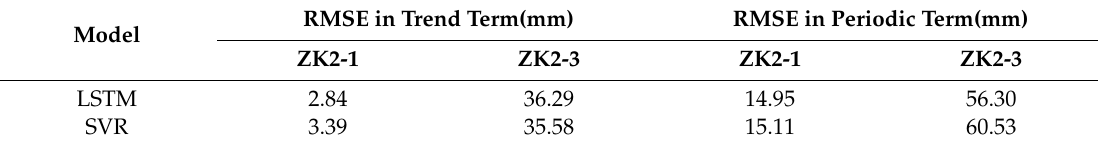
Table 10. Accuracy of the prediction in trend term and periodic term of ZK2-1 and ZK2-3. RMSE in Trend Model